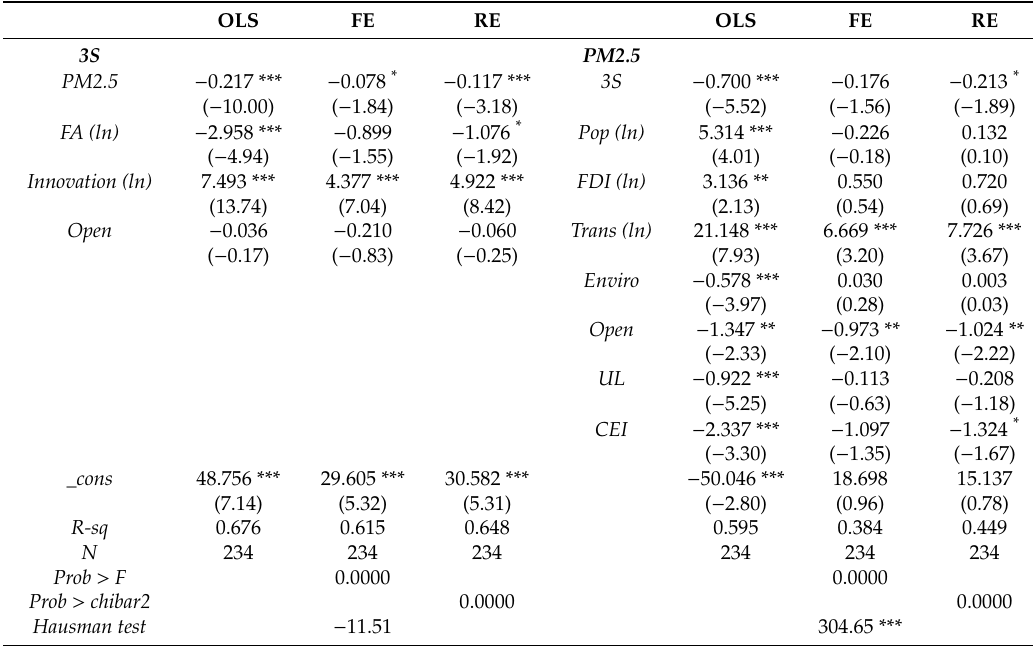
Table 3. Single equation estimation results of tertiary industry and air